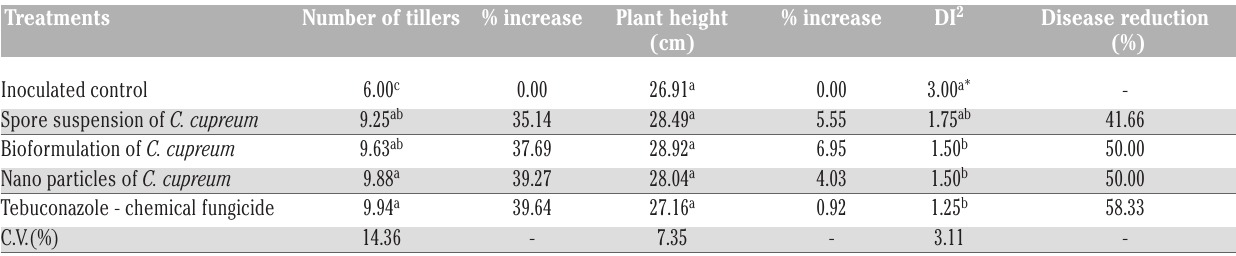
Table 2. Number of tillers, plant height and disease index of rice var. Sen Pidoa in a pot experiment at 65 days. Treatments